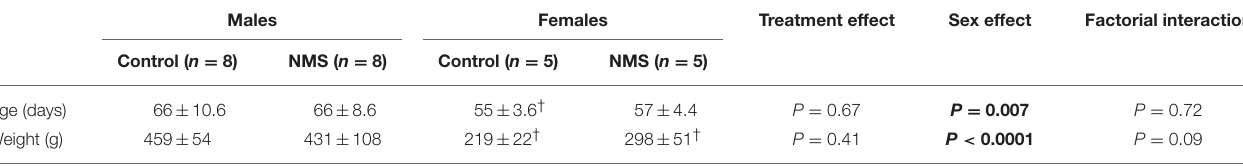
TABLE 1 | Comparison of mean age and weight of animals used to obtain carotid bodies for ex vivo recordings between the different experimental groups. Males Females Treatment effect Sex effect Factorial interaction